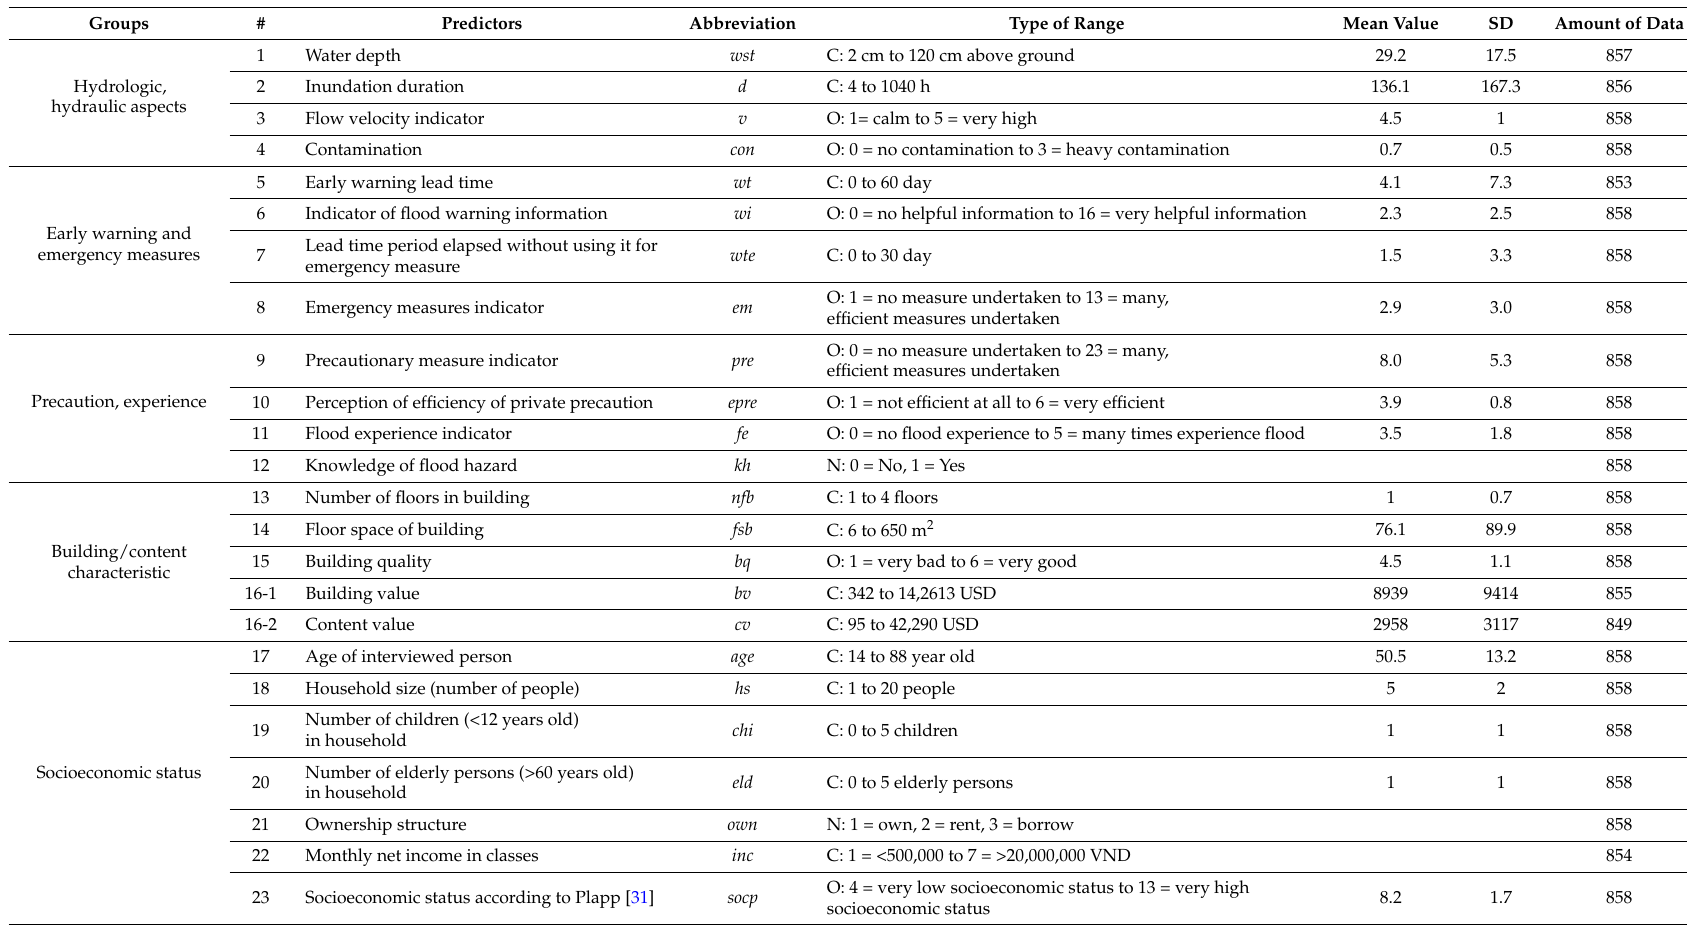
Table 1. Description of the 23 candidate predictors with value range and key statistics (type of scale: C, continuous; O, ordinal; N, nominal).